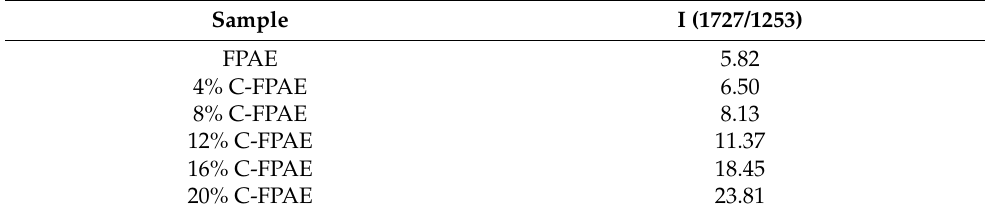
Figure 3 . The cross-linking density, swelling ratio, and sol fraction of the C-FPAE series with differ- ent BDB contents .